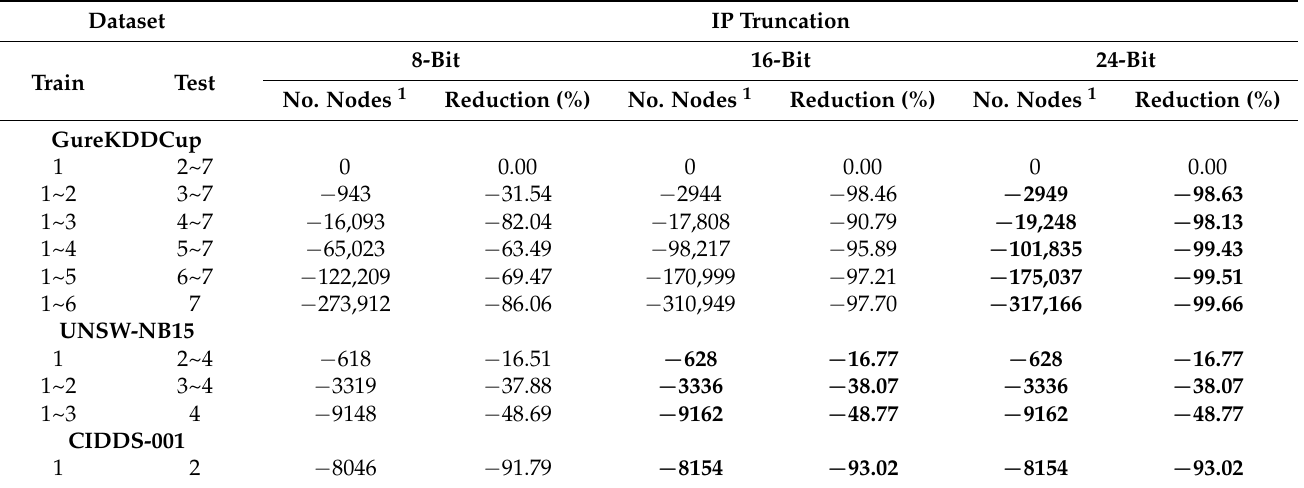
Table 6. Performance Comparison (Number of Nodes) for each C4.5 Model in Full GureKDDCup’99, UNSW-NB15, and CIDDS-001.